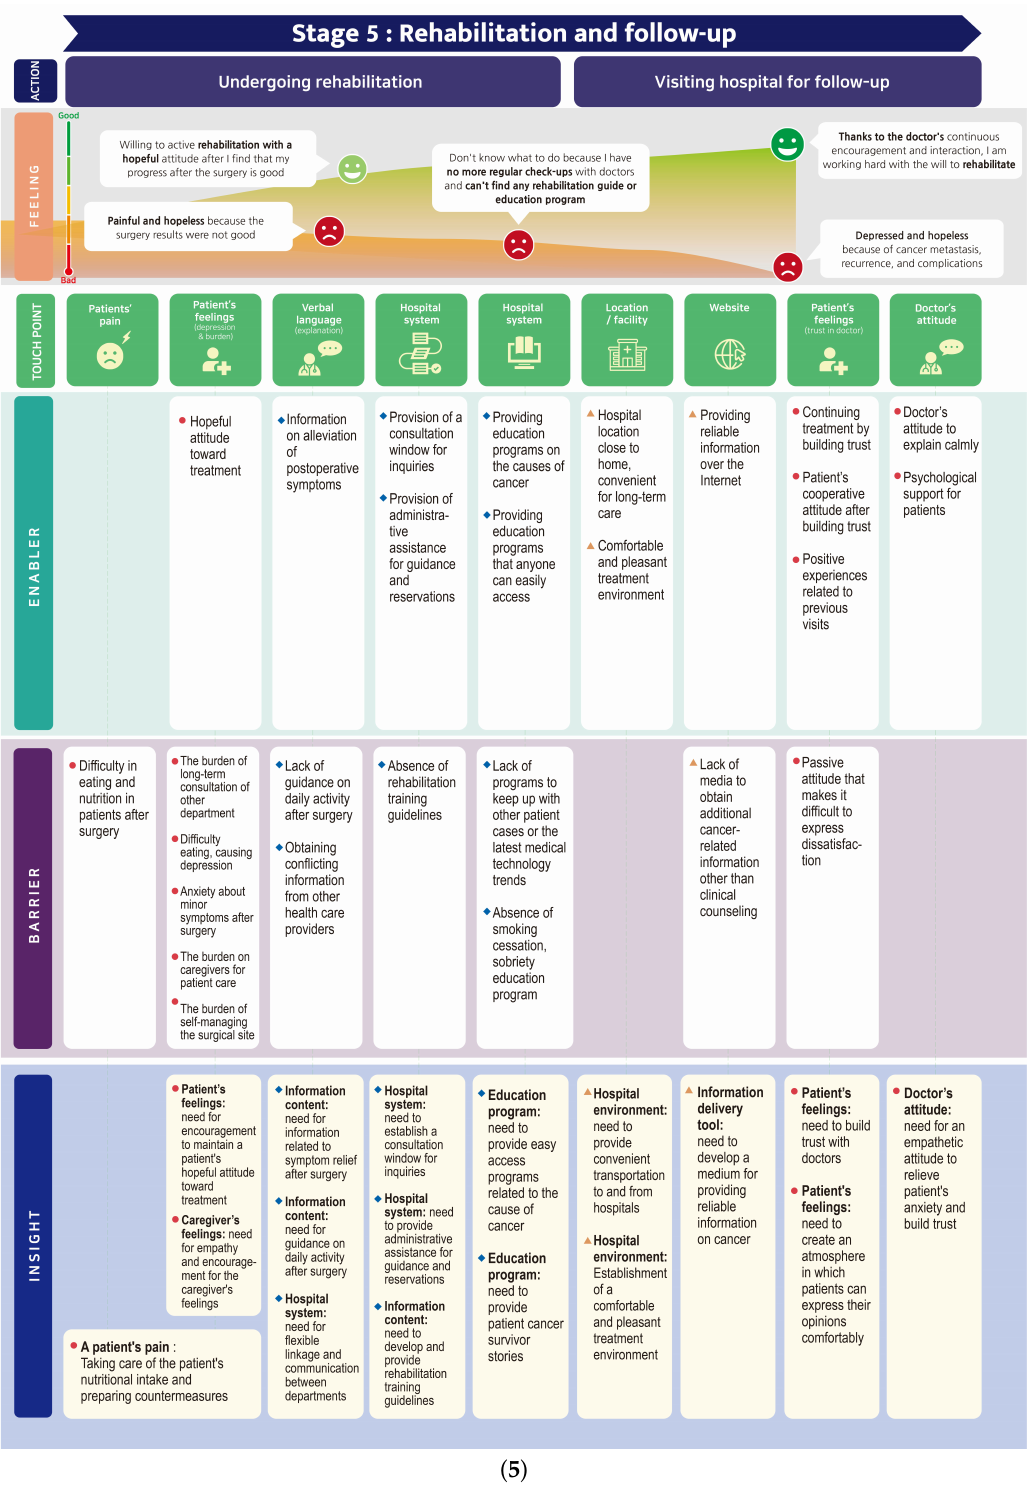
Figure 6. This is a wide figure. Figure 3. ( 1 ) The patient journey map: Stage 1. ( 2 ) Stage 2. ( 3 ) Stage 3. ( 4 ) Stage 4. ( 5 ) Stage